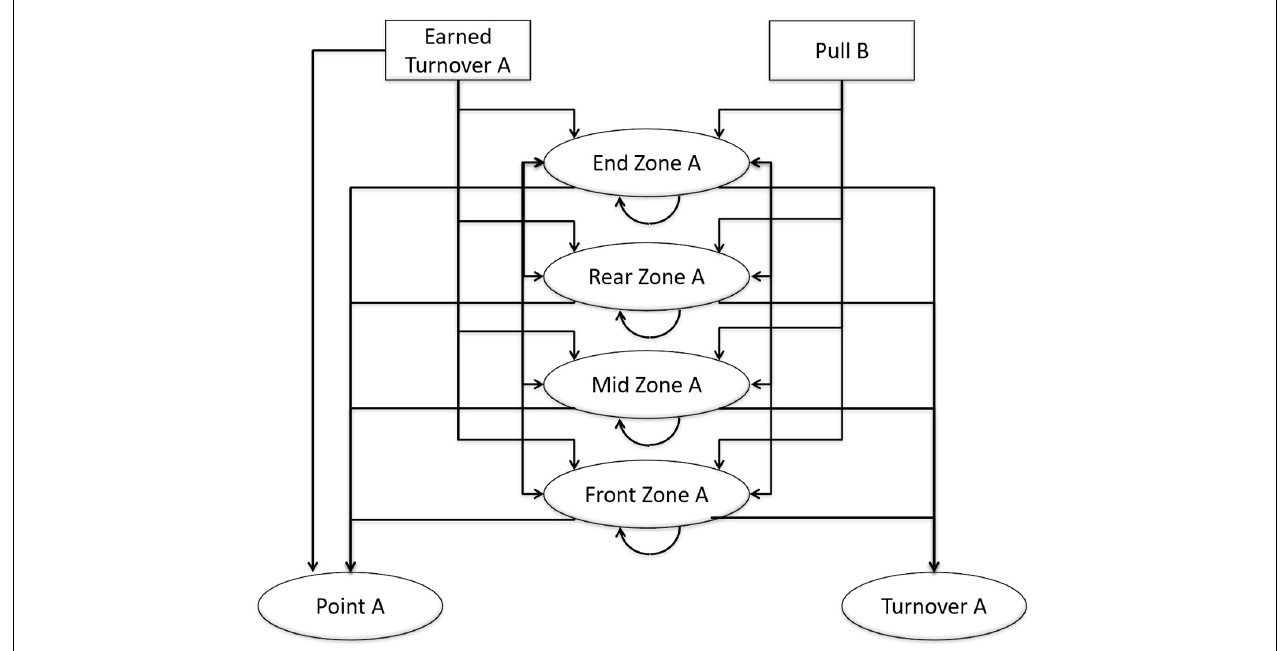
FIGURE 1 | State transition model for analysis of tactical behavior in Ultimate. Labels correspond to initial disc possession by Team A. The same model can be used for initial disc possession by Team B by switching the labels from B → A, A → B.